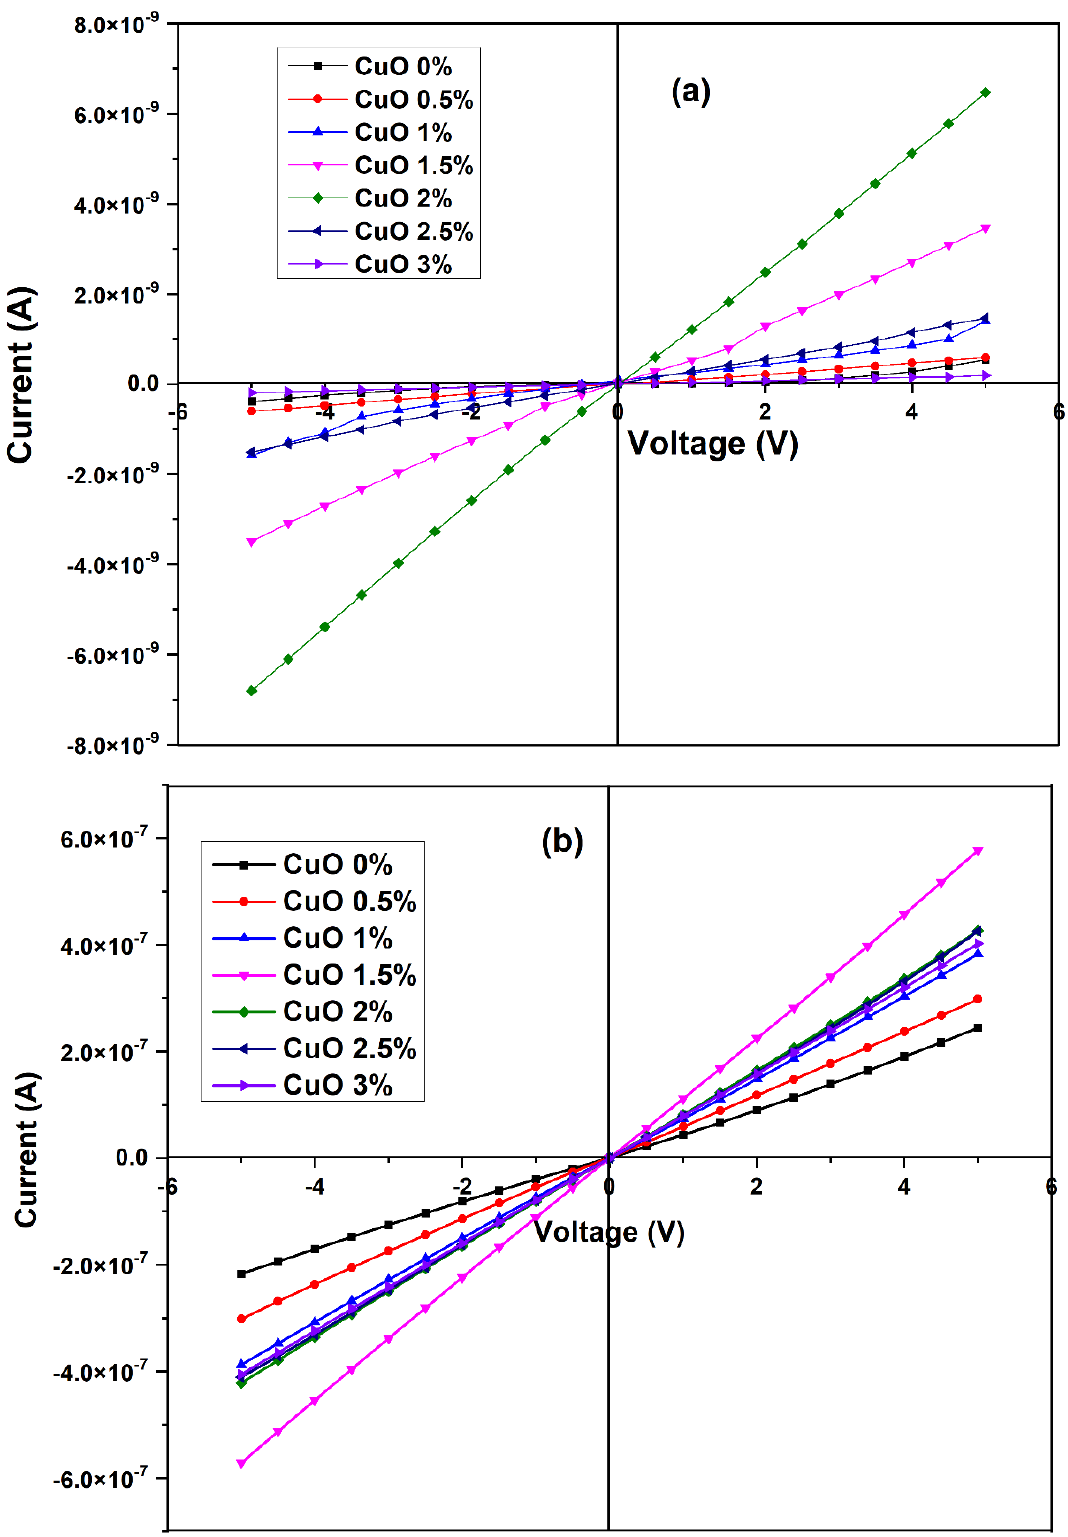
Figure 4. I-V characteristic measurements of CuO films for various Sn content: ( a ) 5 layers and ( b ) 10 layers.